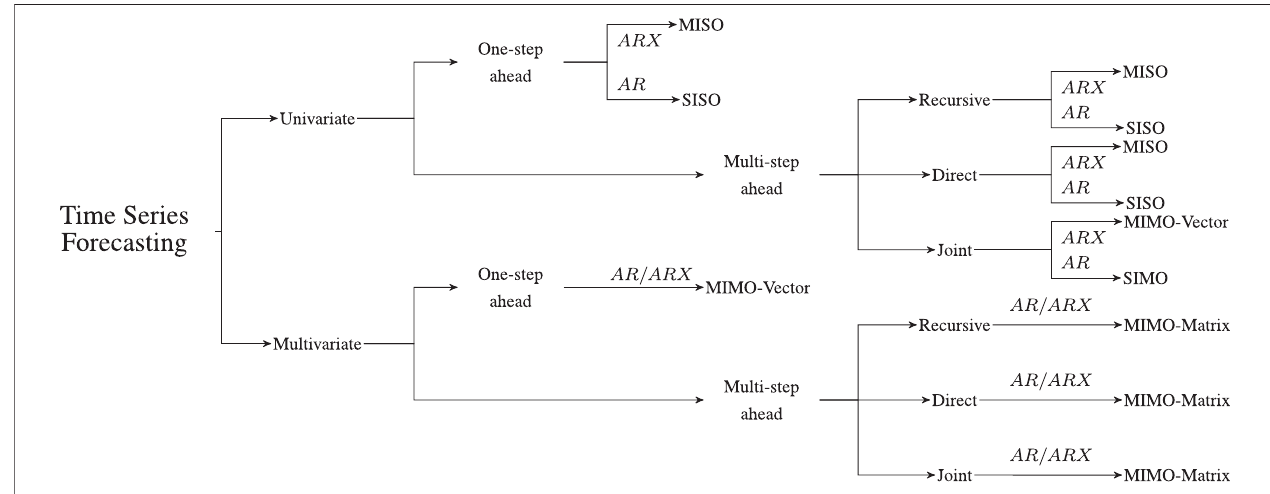
FIGURE 1 | Summary of the different time series forecasting problems and the corresponding tasks. AR indicates an autoregressive hypothesis [i.e. the forecast uses only the information from the past of the considered time serie(s)], while ARX indicates the presence of external regressors.